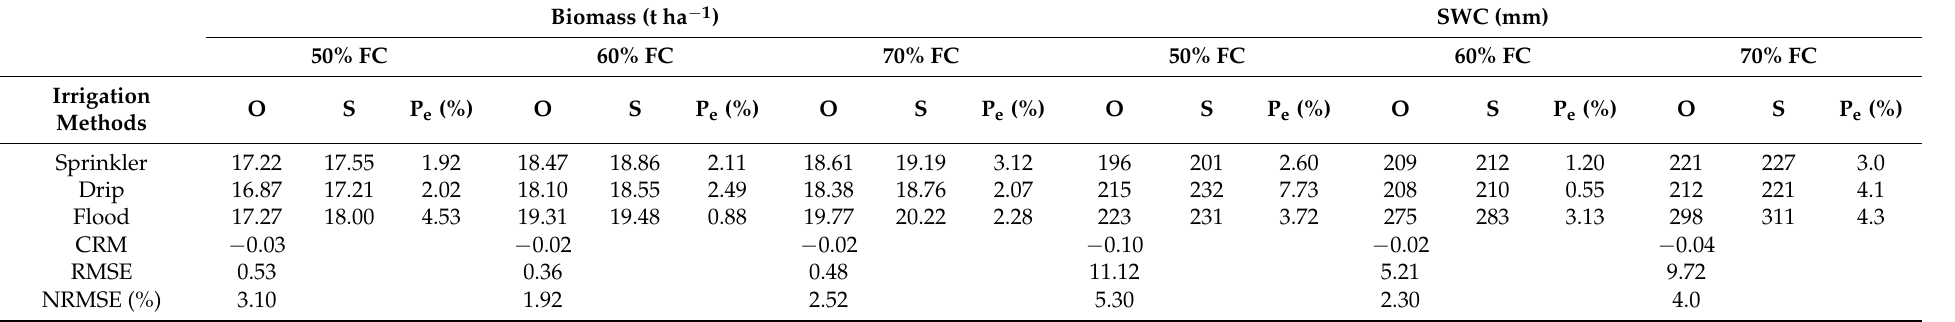
Table 6. Calibration result of biomass and soil water content (SWC) for different irrigation strategies in